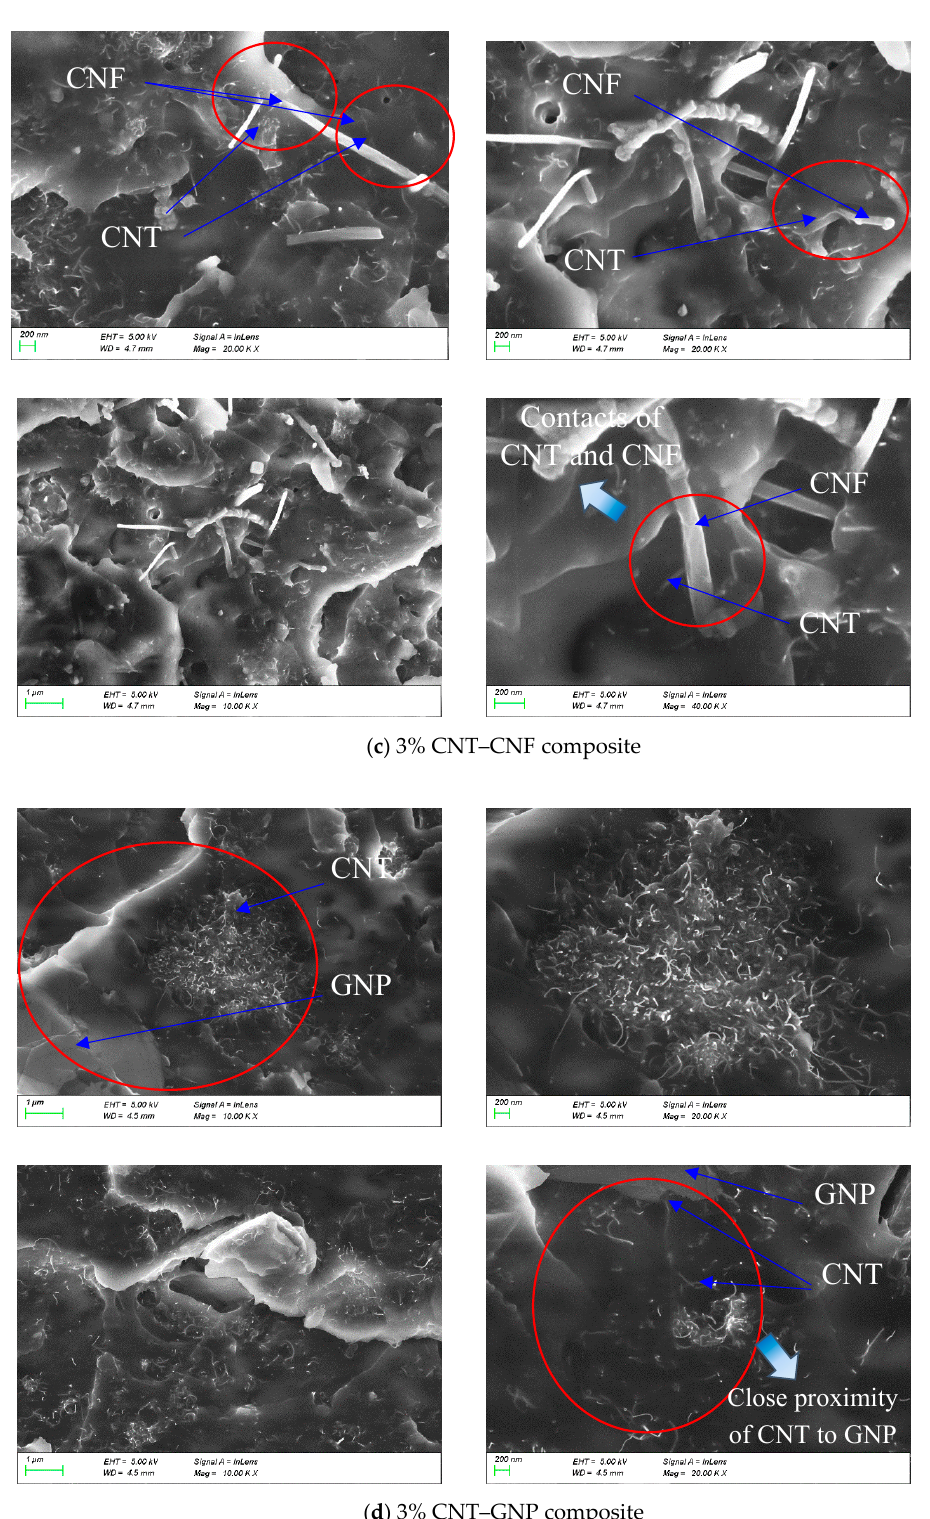
Figure 5. SEM images observed in varied magnifications and obtained from fractured surfaces of ( a ) the epoxy-based composites incorporating 3% CNT-only, ( b ) the epoxy-based composites incorporating 3% CNT–graphene, ( c ) the epoxy-based composites incorporating 3% CNT–CNF, and ( d ) the epoxy-based composites incorporating 3%